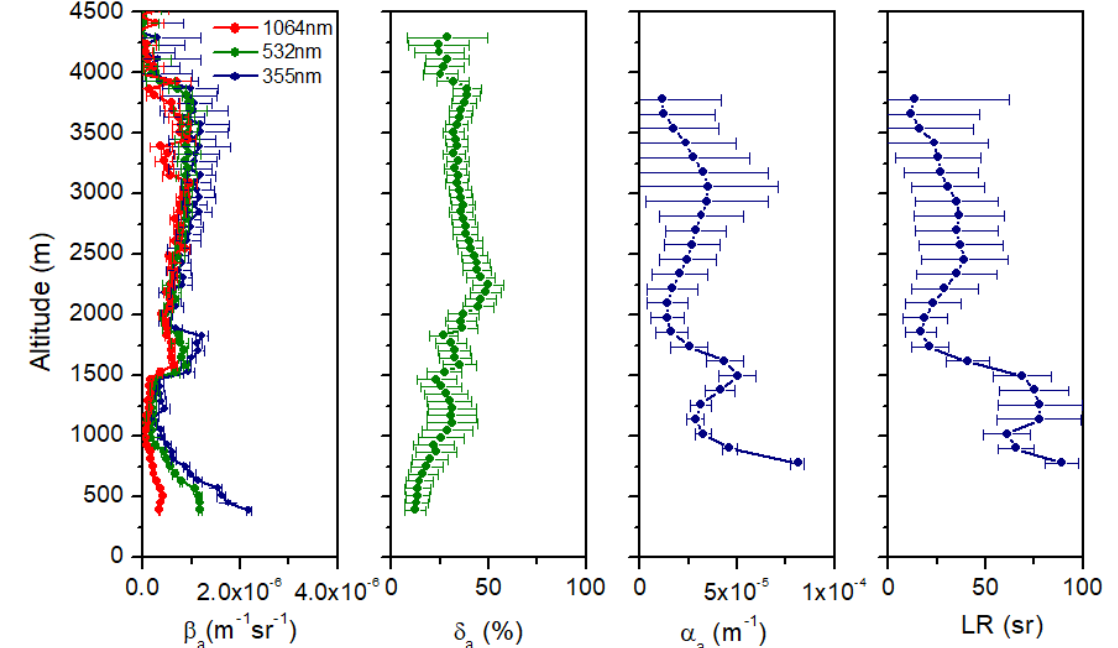
Figure 12. Lidar profiles of aerosol backscattering (backscattering ( β a ), extinction ( α a ), linear depolarization ( δ a ) and lidar ratio (LR)) derived from Raman lidar observations carried out on 10 July 2017 in Naples.